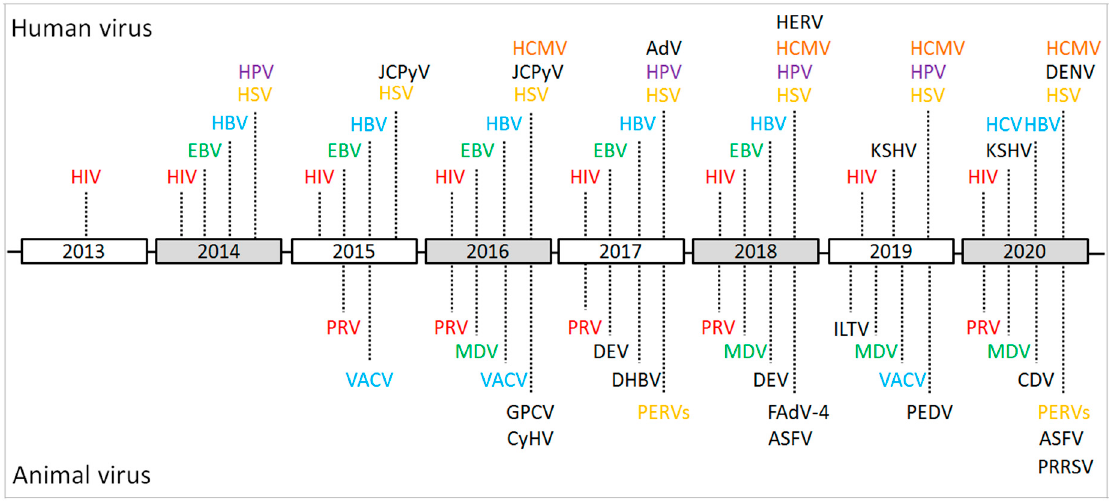
Figure 2. Schematic of the important events and achievements of the CRISPR/Cas9-based gene editing of viral genomes during 2013–2020. HIV: human immunodeficiency virus; EBV: Epstein–Barr virus; HSV: herpes simplex virus; HBV: hepatitis B virus; HCV: hepatitis C virus; HPV: human papillomavirus; HCMV: human cytomegalovirus; JCPyV: JC polyomavirus; KSHV: Kaposi’s sarcoma-associated herpesvirus; AdV: Adenovirus; HERV: human endogenous retrovirus; DENV: dengue virus; PRV: pseudorabies virus; VACV: vaccinia virus; MDV: Marek’s disease virus; GPCV: guinea pig cytomegalovirus; CyHV: cyprinid herpesvirus; DEV: duck enteritis virus; DHBV: duck hepatitis B virus; PERVs: porcine endogenous retroviruses; ASFV: African swine fever virus; FAdV-4: Fowl Adenovirus 4; ILTV: infectious laryngotracheitis virus; PEDV: porcine epidemic diarrhea virus; CDV: canine distemper virus; PRRSV: porcine reproductive and respiratory syndrome